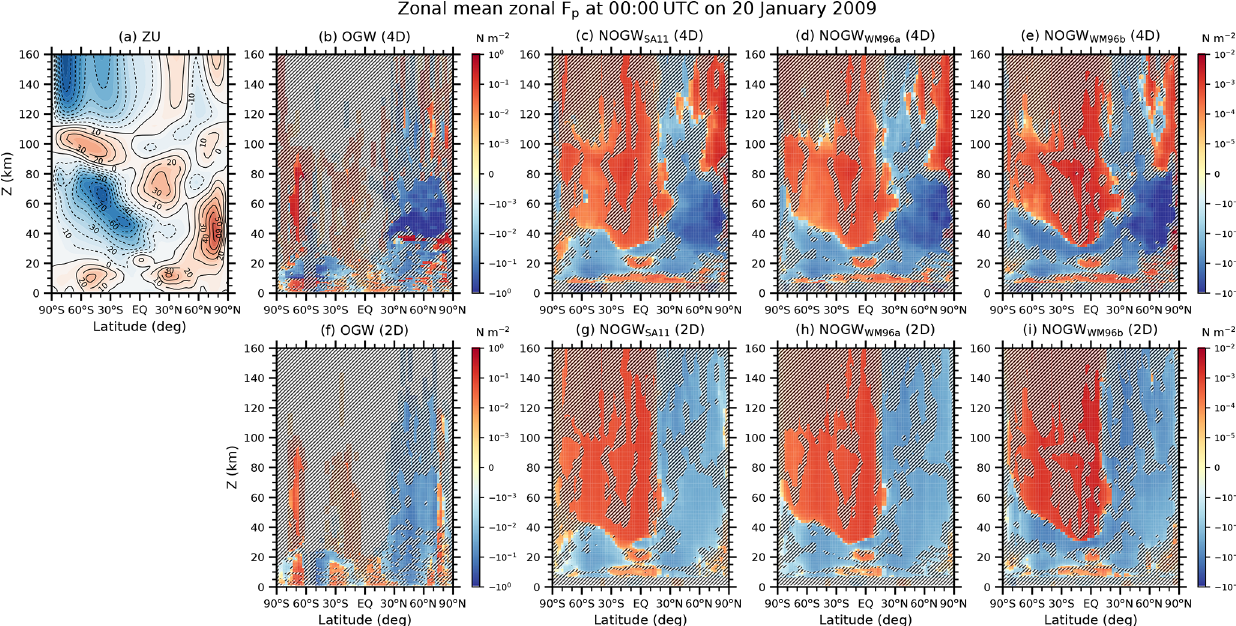
Figure 4. Latitude–height cross sections of (a) zonal mean zonal wind (ZU) and (b–i) zonal mean zonal pseudomomentum fluxes ( F p ) for OGW and three NOGW schemes in the (top row) 4D and (bottom row) 2D experiments at 00:00UTC on 20 January 2009. OGW F p is multiplied by the efficiency factor (0.125). Contour interval of zonal mean zonal wind is 10ms − 1 , and negative values are plotted in broken lines. Hatched areas on the pseudomomentum fluxes indicate regions where the paired and two-tailed t test for 20 ensemble members of the 4D and 2D experiments give p values larger than 0.05 (i.e., no statistical significance at the level of 0.05). Here, the p value means there is a probability that mean values in the 4D and 2D experiments would be similar to each other. The hatched areas are identical in the pair of 4D and 2D experiments for a particular GW scheme. A non-parameteric test, such as Wilcoxon’s signed rank test, where no probabilistic distribution is assumed, also gives almost similar results to the t test. For these statistical tests, algorithms presented in Boslaugh (2013) are